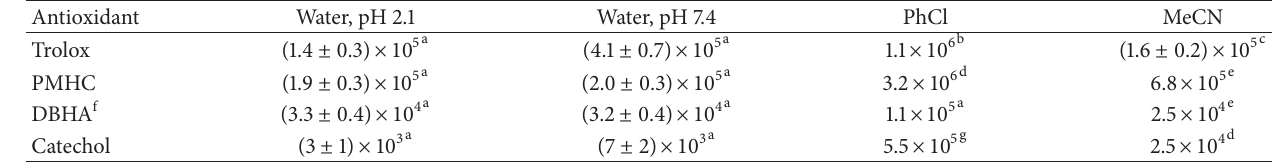
Table 3: Propagation ( 𝑘 𝑝 /M −1 s −1 ) and termination ( 2𝑘 𝑡 × 10 −6 / M −1 s −1 ) rate constants for the autoxidation of 1,4-cyclohexadiene in different solvents and corresponding rate constants for the reaction of PMHC with hydroperoxyl radicals ( 𝑘 30 ∘